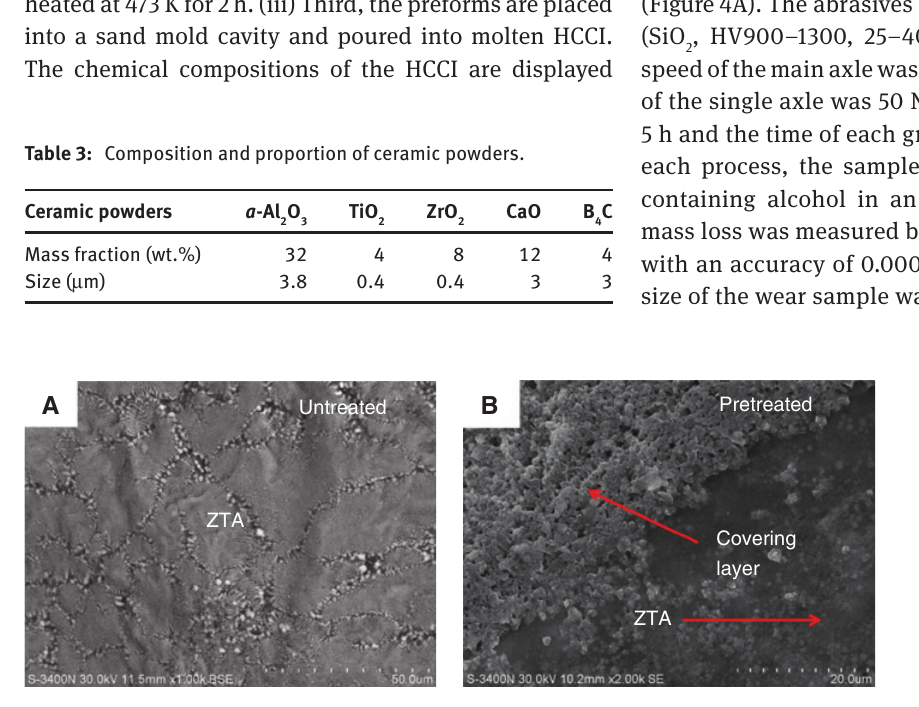
Figure 3: ZTA particles: (A) untreated; (B) pretreated.